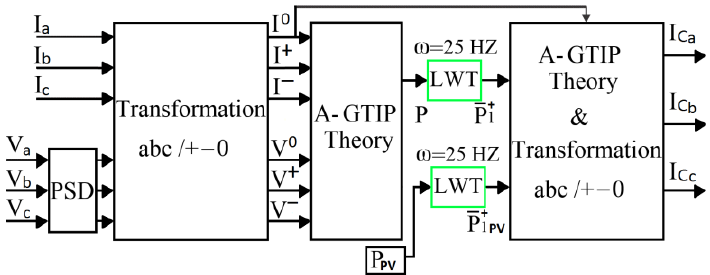
Figure 3. Block diagram of the advanced generalized theory of instantaneous power (A-GTIP) compensation algorithm equipped with wavelet-based filter.